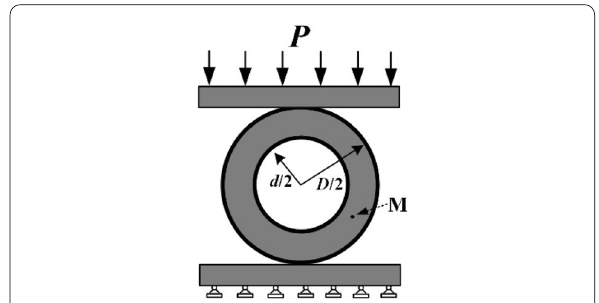
Figure 1 Schematic of the